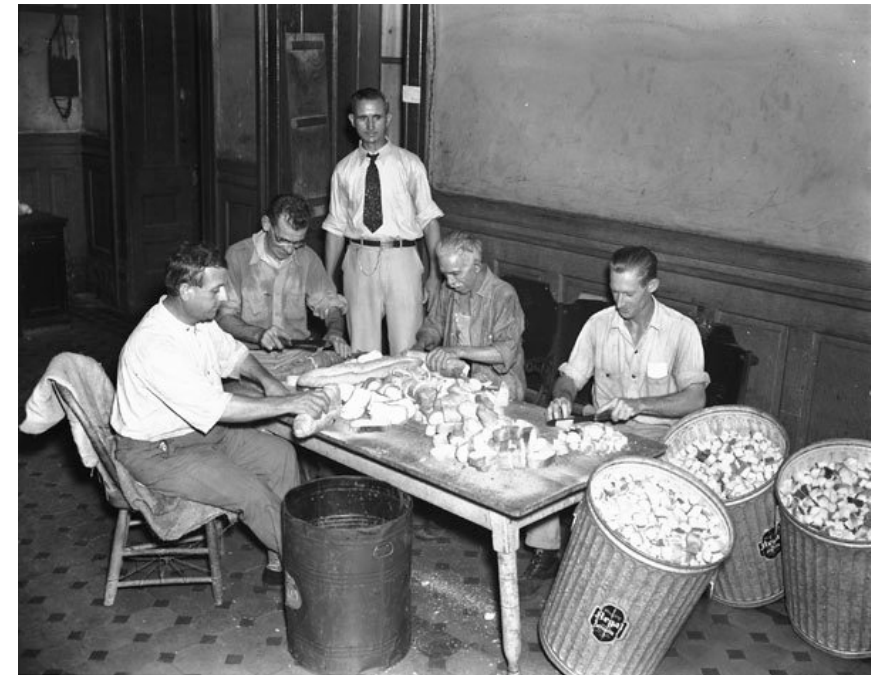
Figure 5. Works Progress Administration workers preparing rodenticide torpedoes (typically a mixture of red squill with either meat, fish, or grain, wrapped in paper), New Orleans, 1936.